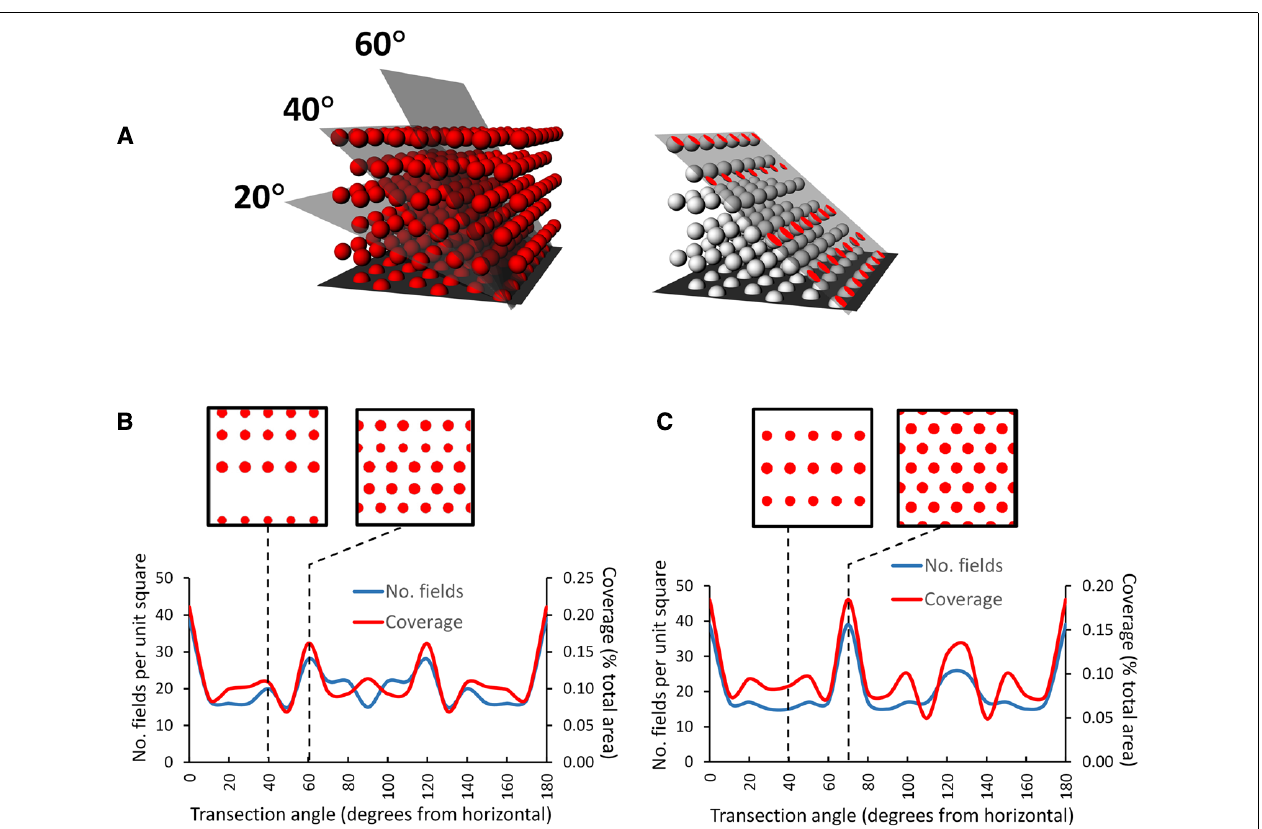
FIGURE 7 | Pattern of grids seen if a horizontally aligned volumetric close-packed grid lattice, with “fields” of diameter of half the inter-center distance, is transected at different angles by a square planar surface. (A) A transection square (simulating a sloping surface that a rat might walk on) was aligned with a row of simulated grid fields and then tilted by various increments through the HCP lattice. On the right is the intersection (shown in red) of the tilted plane with some of the grid fields, generating an imaginary grid cell firing pattern which can be analyzed to yield the percentage of the surface covered (“coverage”) and the number of fields. (B) HCP lattice: the line graph shows that the transection patterns for both coverage and field number are mirror-symmetric around 90°. Note that in this case, only the